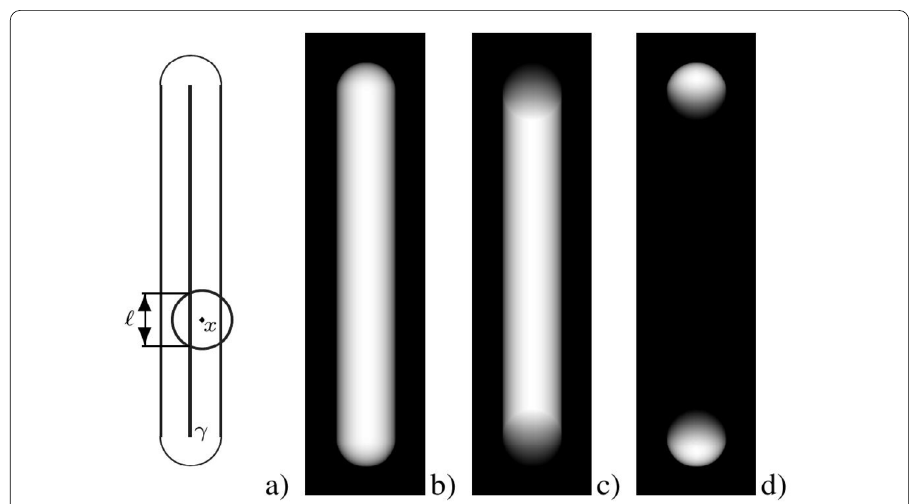
Figure 3 Modeling the local grammage of a straight fiber: a) the core γ and the contour of the fiber model γ ⊕ B R , b) the projection of the fiber model on the plane R 2 , c) the core convolved with the filter mask κ ( x ), d) the difference between projection and filtering. The filter response in x is the length (cid:13) of the core γ intersected with the circle divided by the area of the